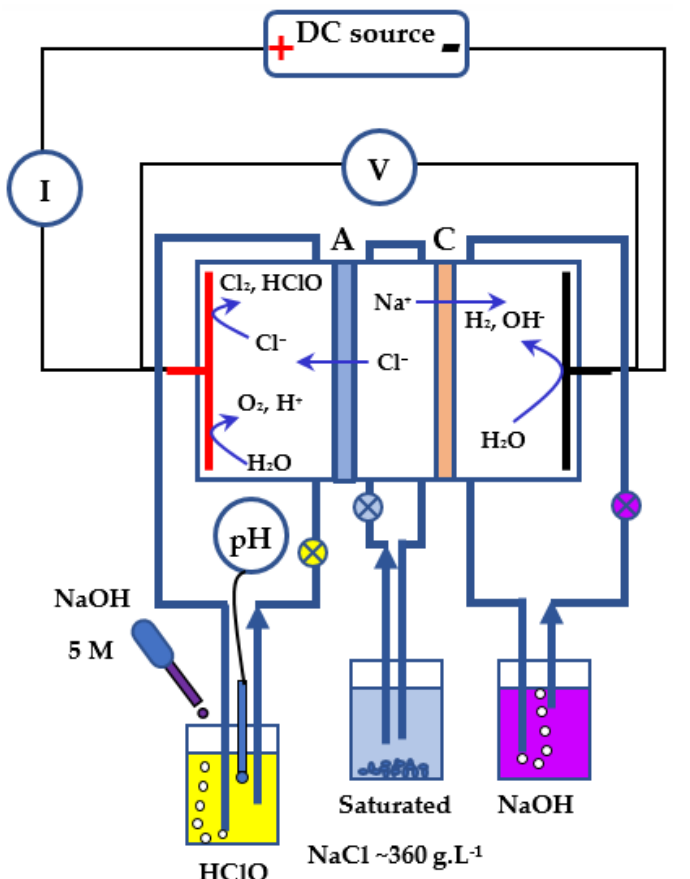
Figure 2. Experimental device with its measurement instruments and solutions circulations, and pH control system of the HClO compartment.